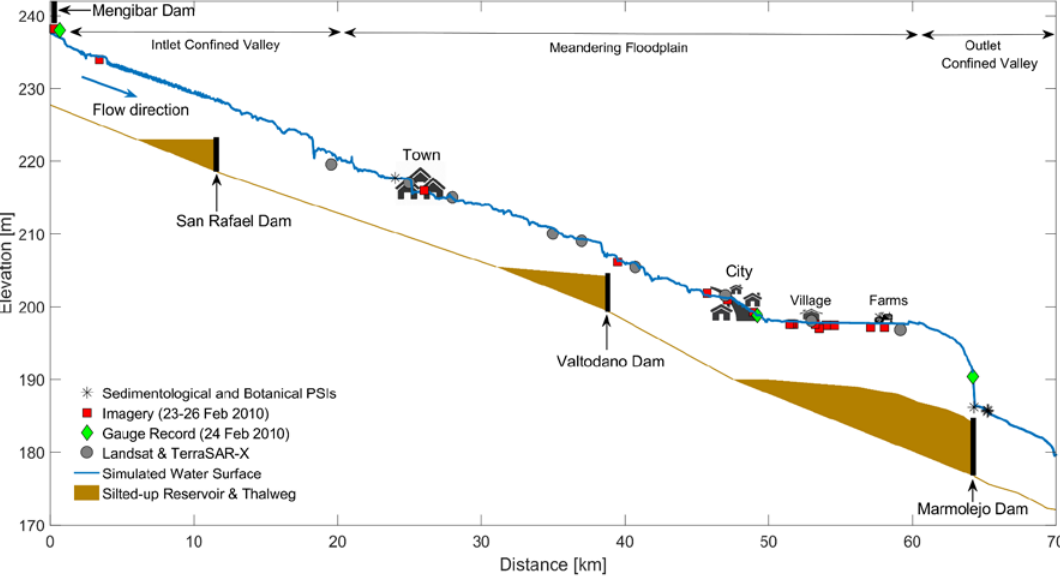
Figure 3. Longitudinal profile of maximum water levels in the numerical flood simulation (solid blue